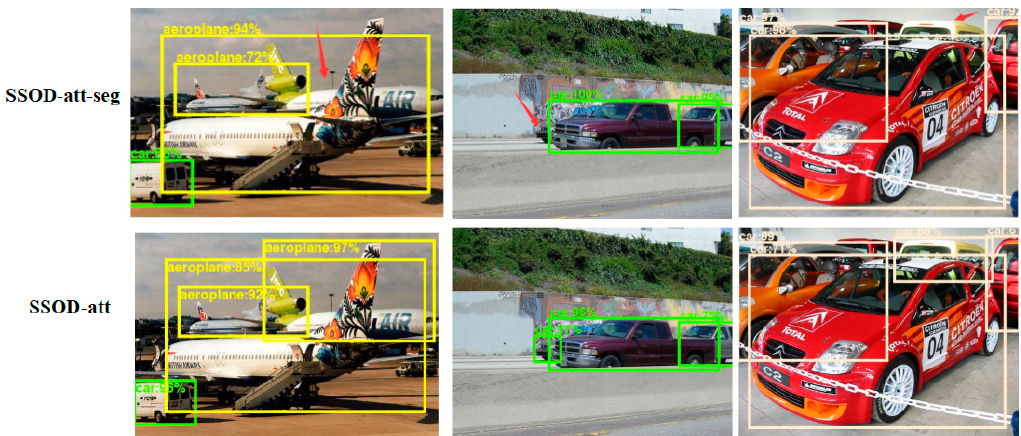
Figure 6. Comparison of detection effect between the SSOD-att-seg algorithm and SSOD-att algorithm. The arrows indicate the objects detected by the SSOD-att algorithm but missed by the SSOD-att-seg algorithm.